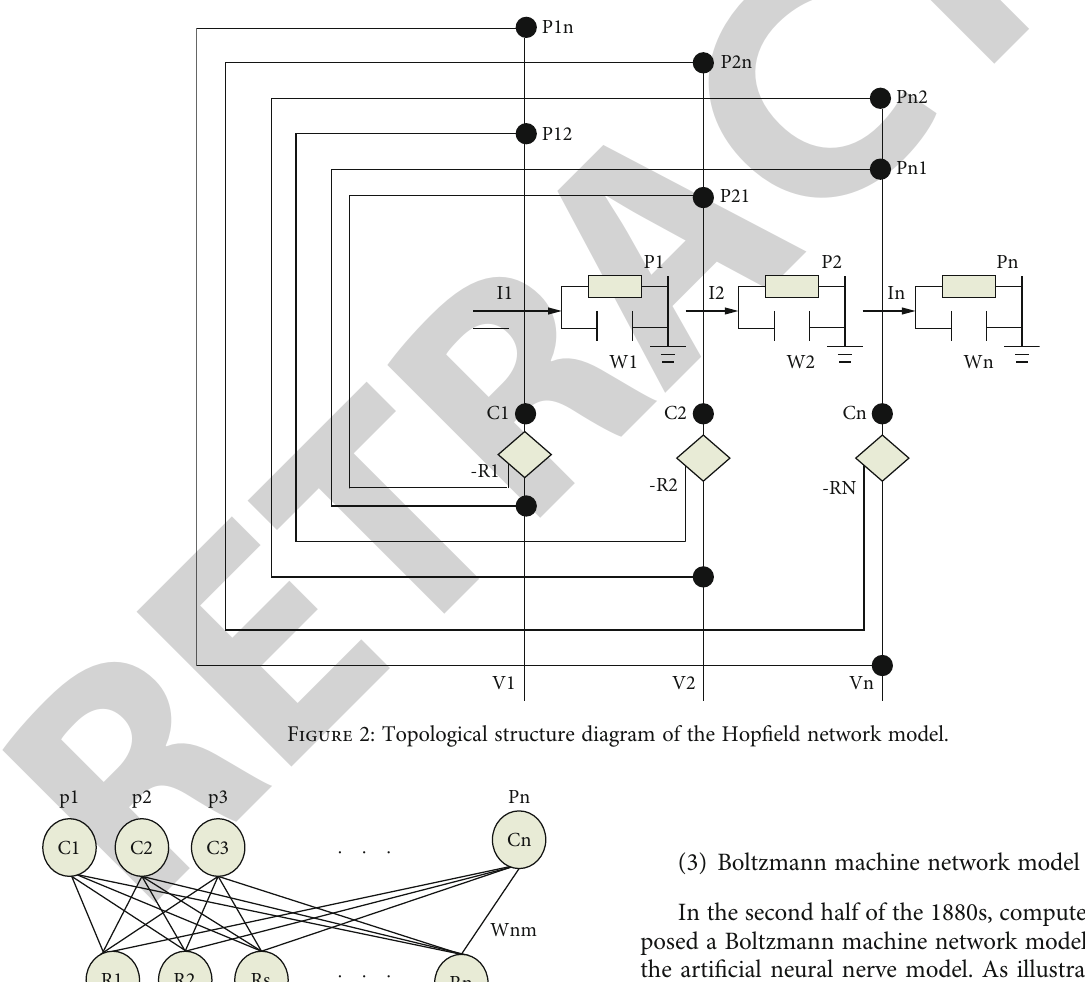
Figure 3: Topological structure diagram of the Boltzmann machine network